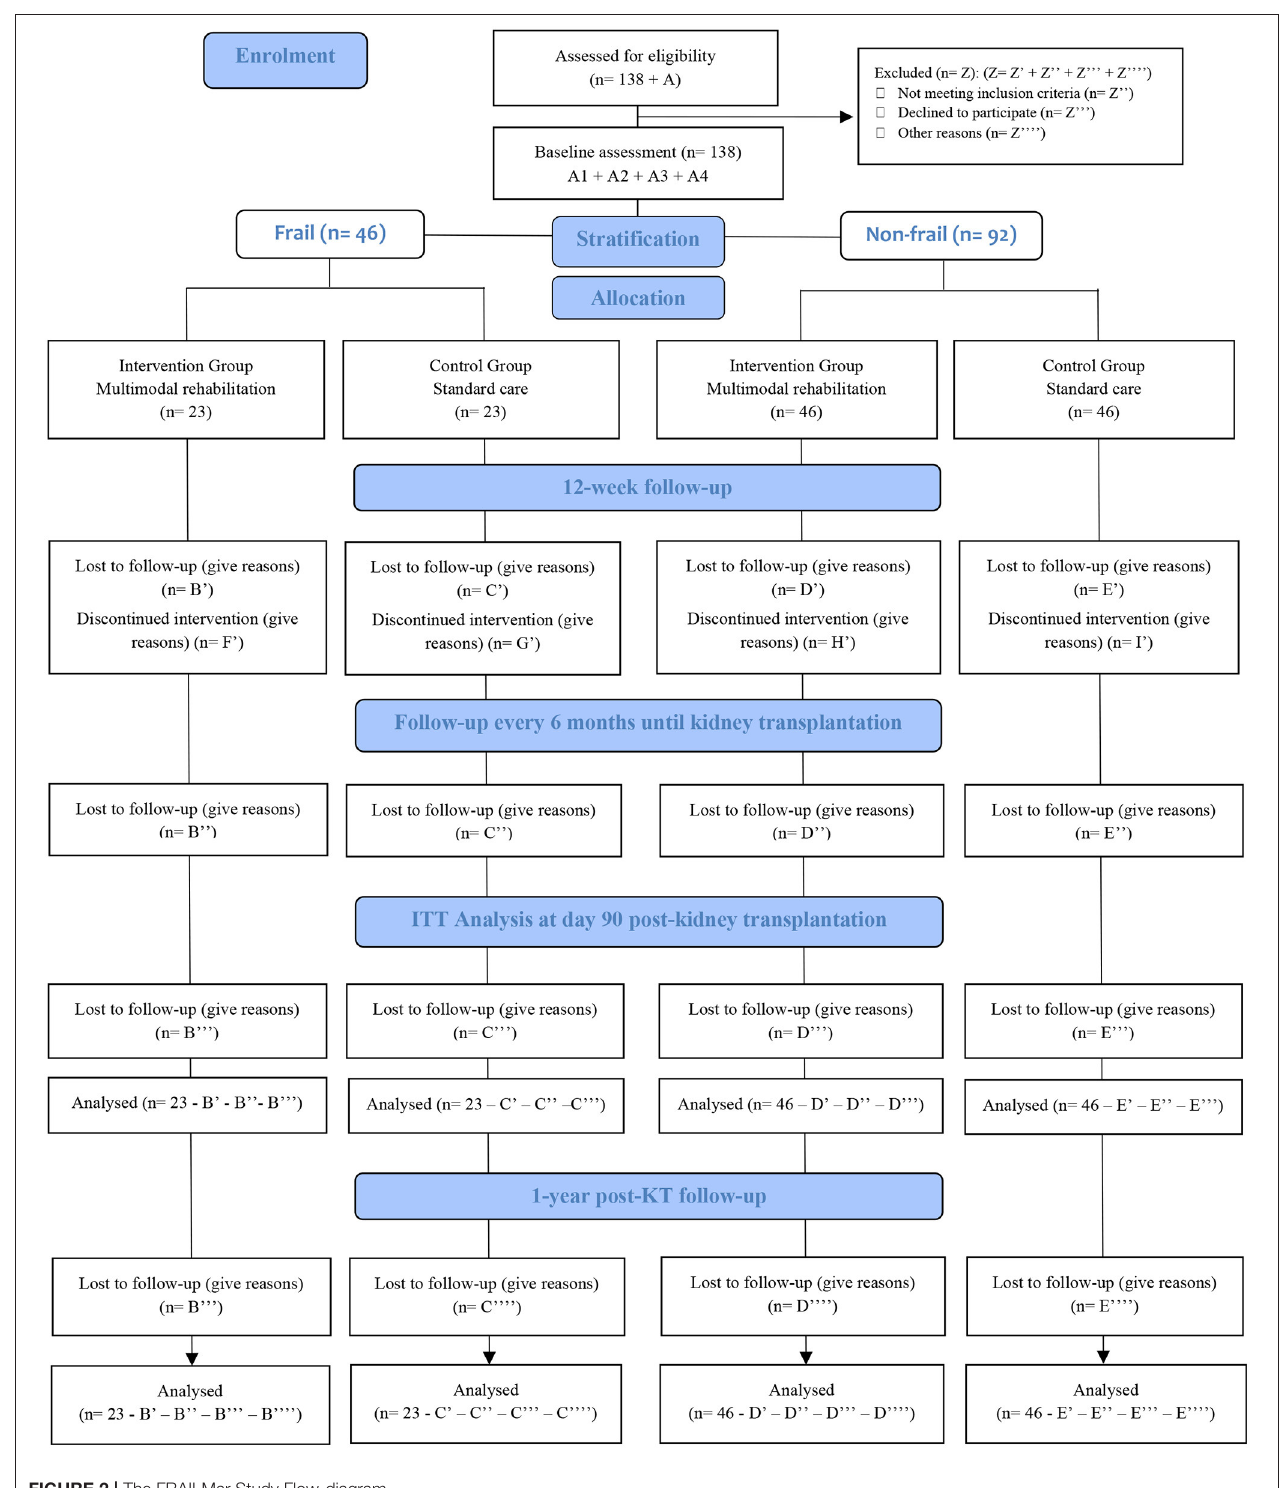
FIGURE 2 | The FRAILMar Study